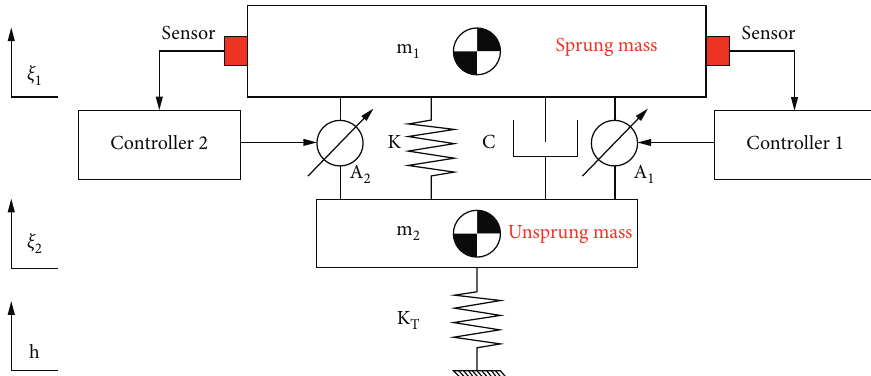
Figure 1: Quarter vehicle dynamic model.